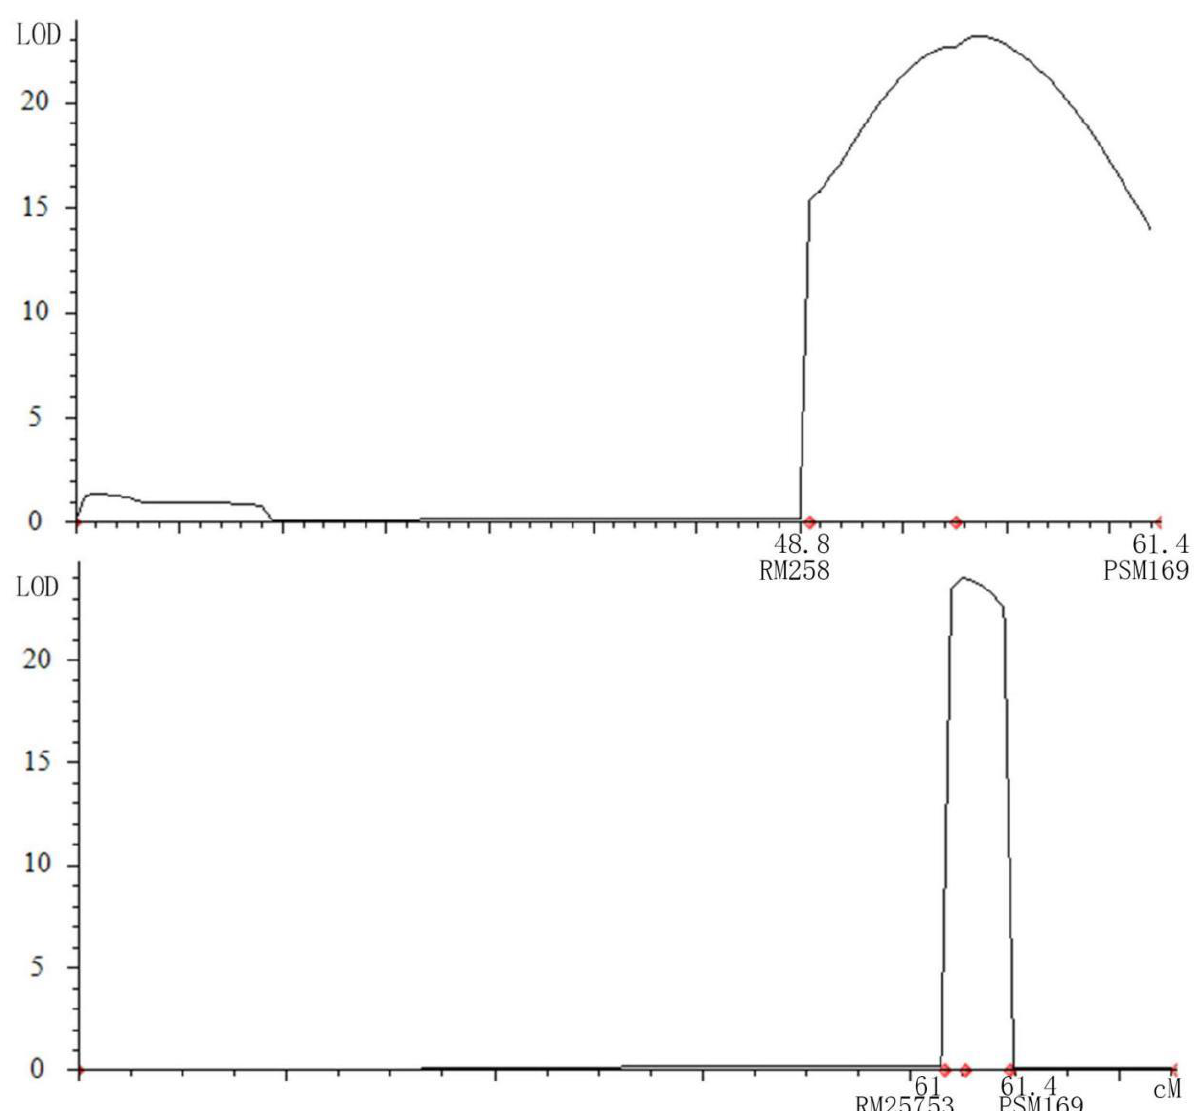
Figure 3. Putative location of the QTL for grain shape in S24. ( Up ) Mapped in 2018; ( Down ) mapped in 2019. Genetic distance (in cM, centimorgans) between two molecular markers is indicated on the X -axis. LOD is abbreviation of the logarithm/likelihood of odds on the Y -axis. The red symbols indicate marker sites or peak locations.